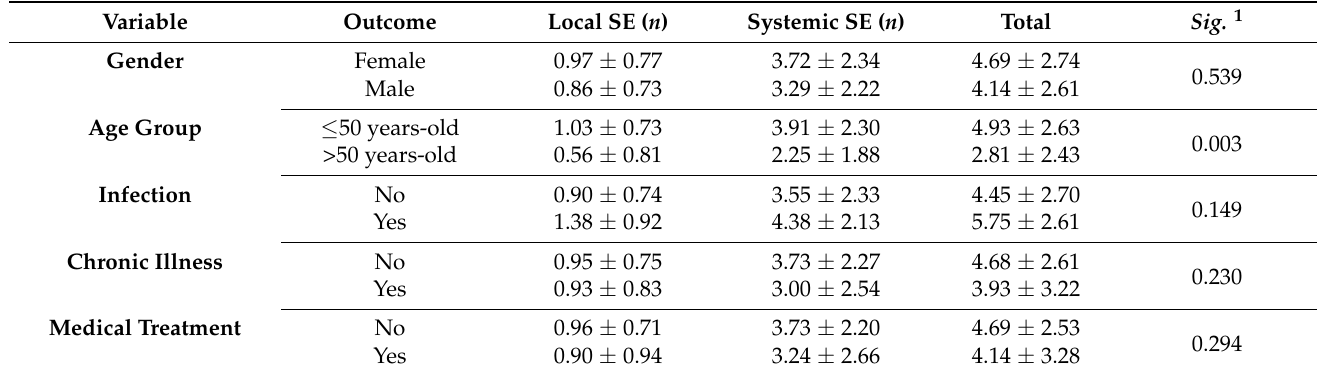
Table 5. Risk factors of AstraZeneca COVID-19 vaccine side effects among European healthcare workers, February–March